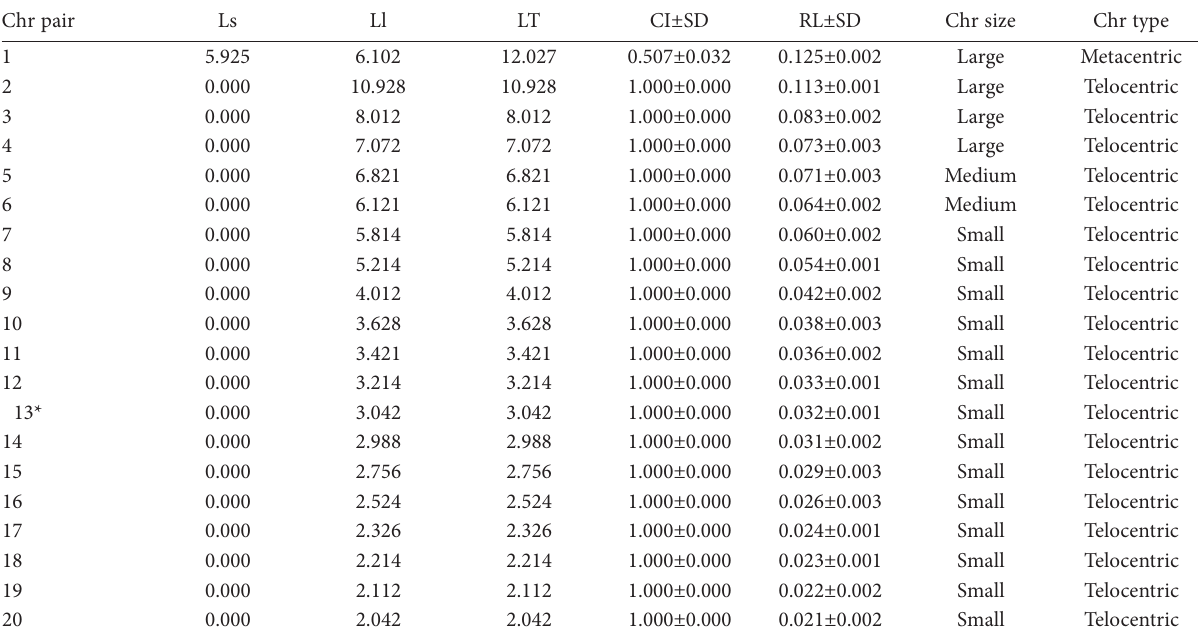
Table 2. Mean length of short arm chromosome (Ls), long arm chromosome (Ll), length of total chromosomes (LT), centromeric index (CI), relative length (RL) and standard deviation (SD) of CI and RL from 20 metaphases of male and female Siamese leaf-toed gecko ( Dixo- nius siamensis ), 2n=40.